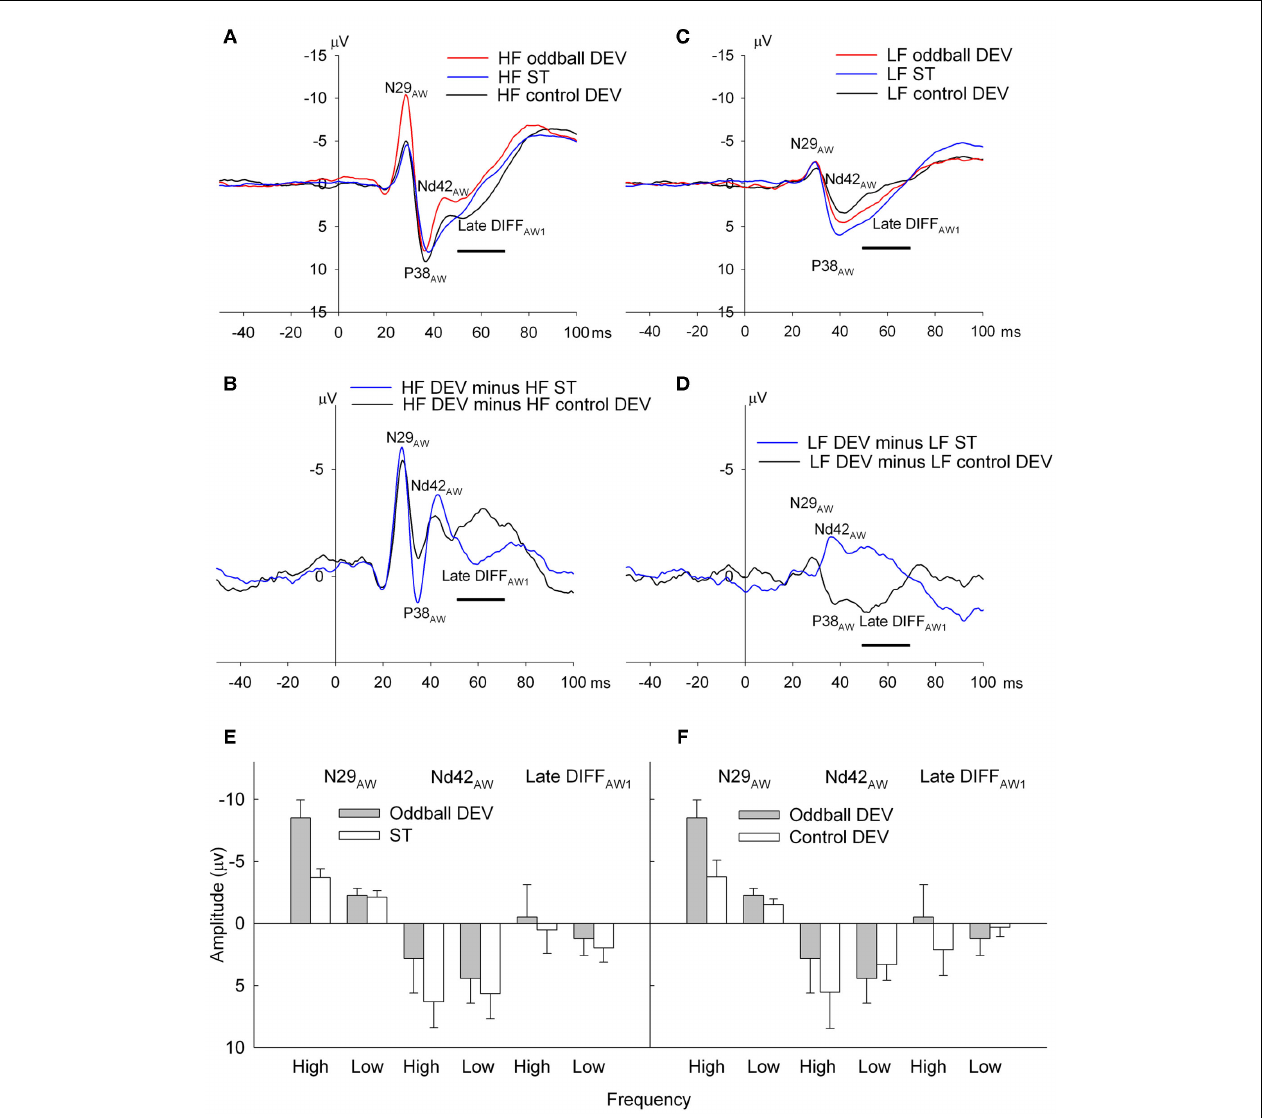
FIGURE 4 | Epidural recorded ERPs in the awake rat to oddball deviant (oddball DEV), standard (ST) and control deviant (control DEV) in the frequency conditions. (A) ERPs to high frequency (HF) stimuli. N29 AW , Nd42 AW , and late DIFF AW1 are all more negative in the oddball DEV ERP (red) than in the ST (blue) and control DEV (black).The black horizontal bar depicts the latency window over which late DIFF AW1 was measured. (B) MMN difference waves for HF stimuli: HF oddball DEV minus HF ST (blue), which can reflect both deviance detection and adaptation effects vs. difference waves derived using control deviants, HF oddball minus HF control DEV (black), which reflects deviance detection. (C) ERPs to low frequency (LF) stimuli. N29 AW , Nd42 AW , and late DIFF AW1